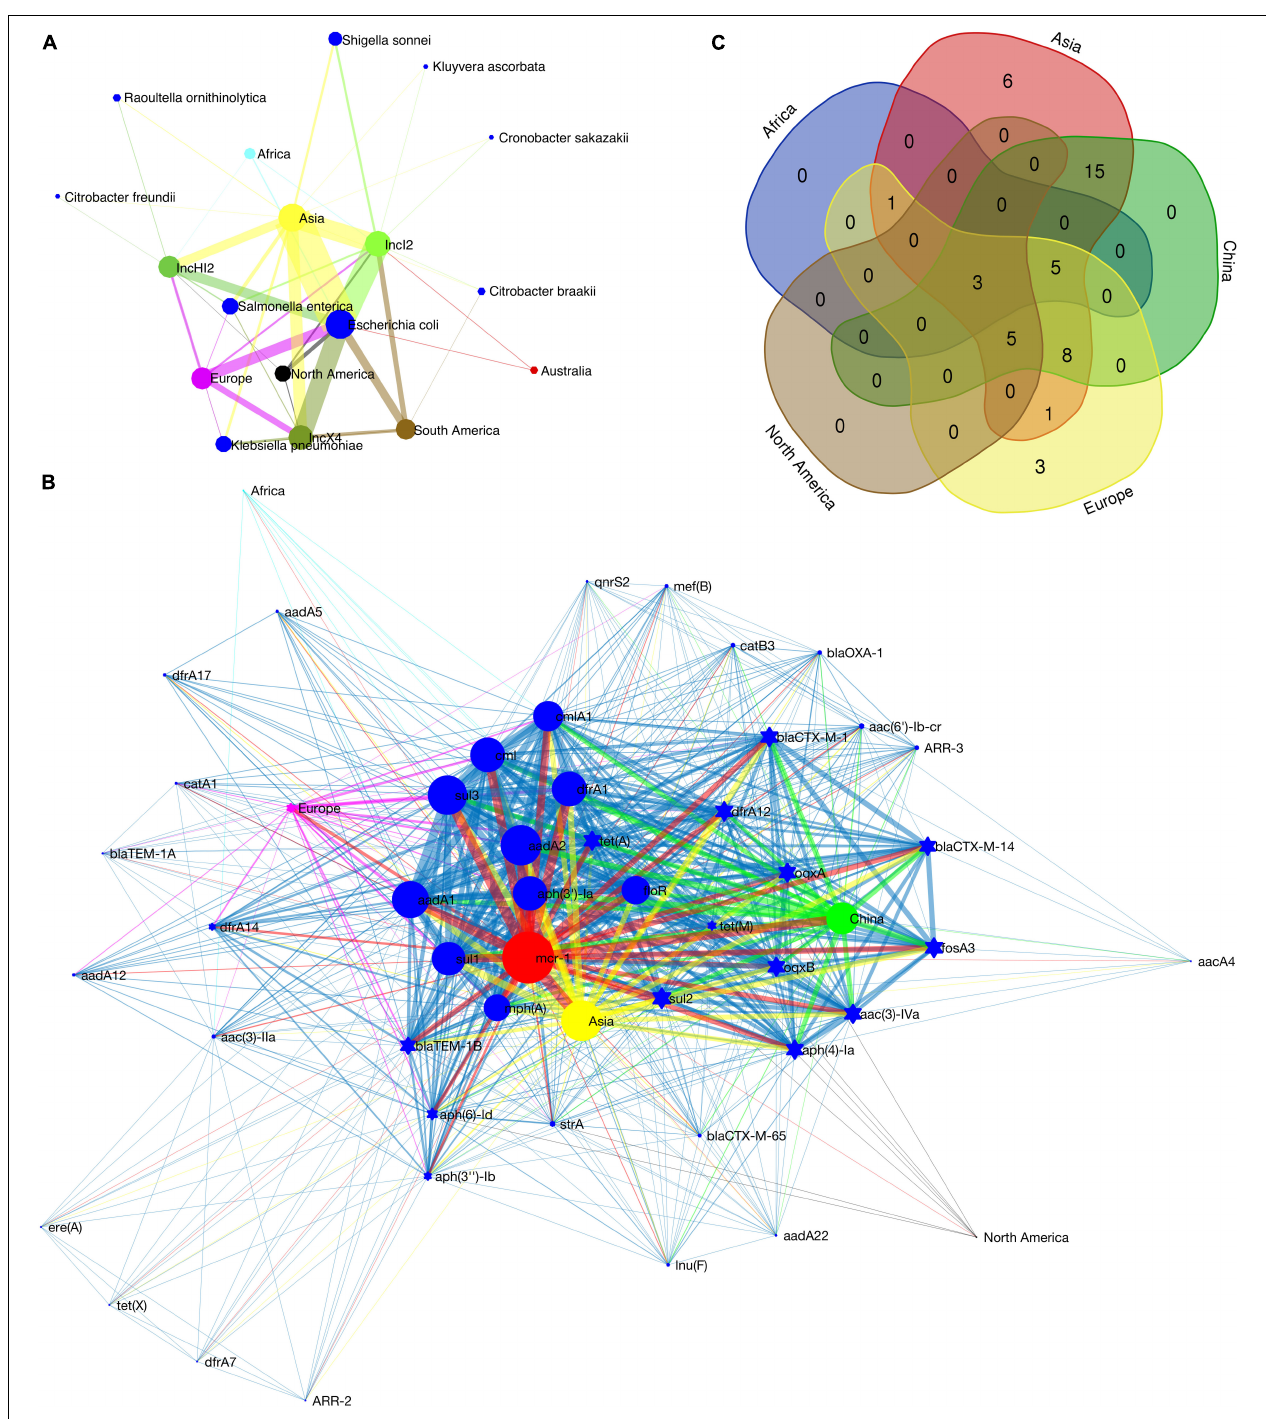
FIGURE 2 | Detection rate of mcr-1 -bearing plasmids in various bacterial host species on different continents (A) , co-occurrence network of mcr-1 with additional ARGs on IncHI2 plasmids (B) and Venn diagram showing the numbers of shared and unique additional ARGs on IncHI2 plasmids at different regions (C) . In (A) , the size of the nodes (plasmid type, bacterial species or continent) is proportional to their detection rate (log-transformed), and the width of the edge between two nodes is proportional to the detection rate of one node (plasmid type or bacterial species) from another (bacterial species and/or continent). Blue nodes indicate bacterial species, green of different saturations the plasmid types and the nodes of other colors the continents. In (B) , the size of the nodes (ARG or geographical region) indicates the frequency of their occurrence, and the width of the edges is proportional to the co-occurrence rate between two nodes (between two ARGs or between an ARG and its location). Blue nodes indicate additional ARGs, red the mcr-1 gene and the nodes of other colors the geographical regions. Ten most frequently occurred ARGs are shown as blue circles.